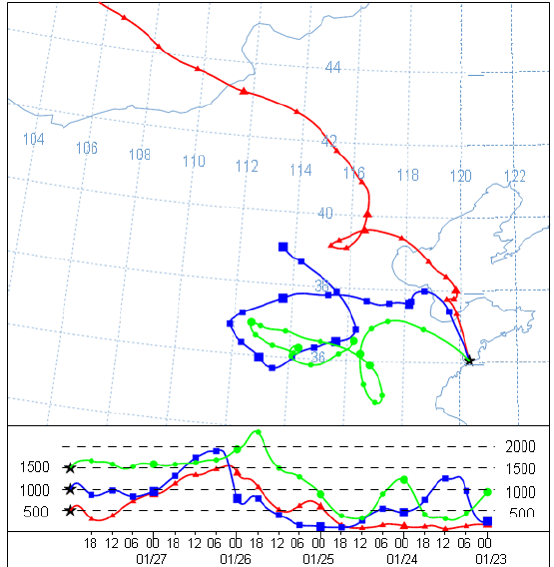
Figure 4. Typical air mass backward trajectories and their source directions during the sampling periods.